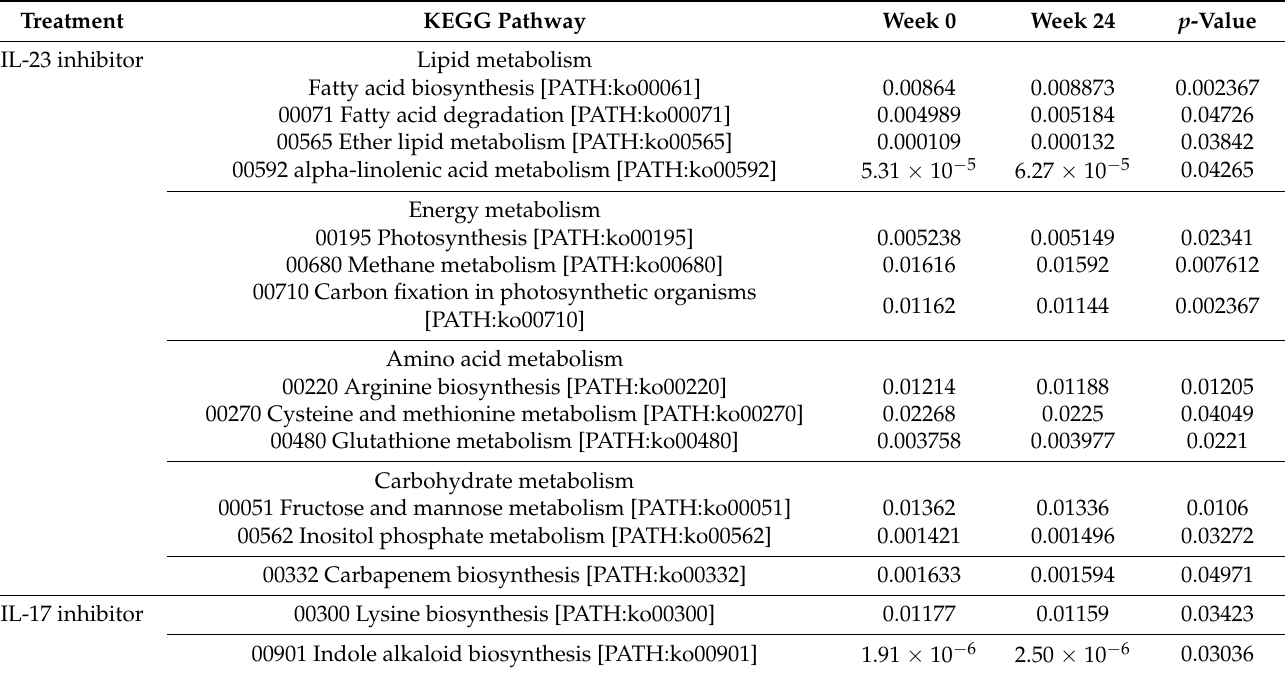
Table 2. Comparison of KEGG metabolism pathways of fecal microbiota between week 0 and week 24 post-treatment in psoriasis.